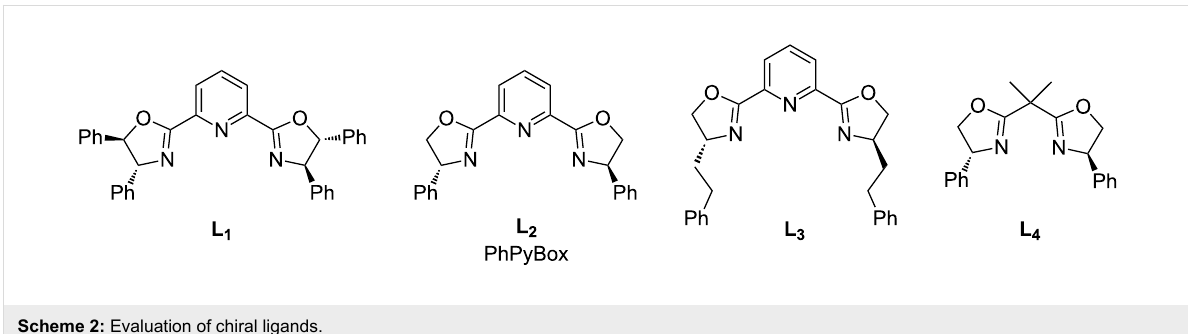
Scheme 2: Evaluation of chiral